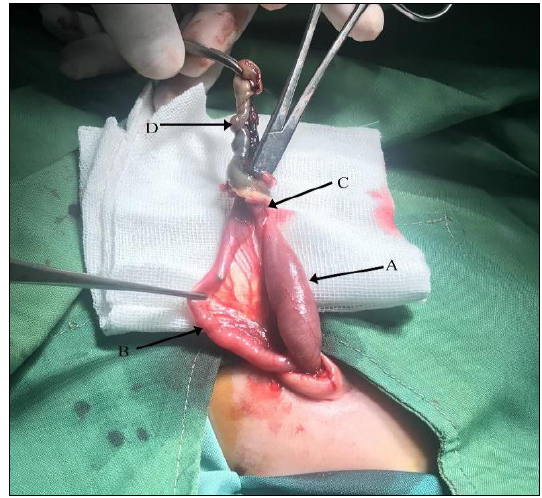
Figure 2: Mucosal prolapse of distal ileum (B) through the patent vitellointestinal duct (C). A: Proxi- mal intestine, B: Distal intestine, C: Patent vitelline duct, D: Congested cord and its